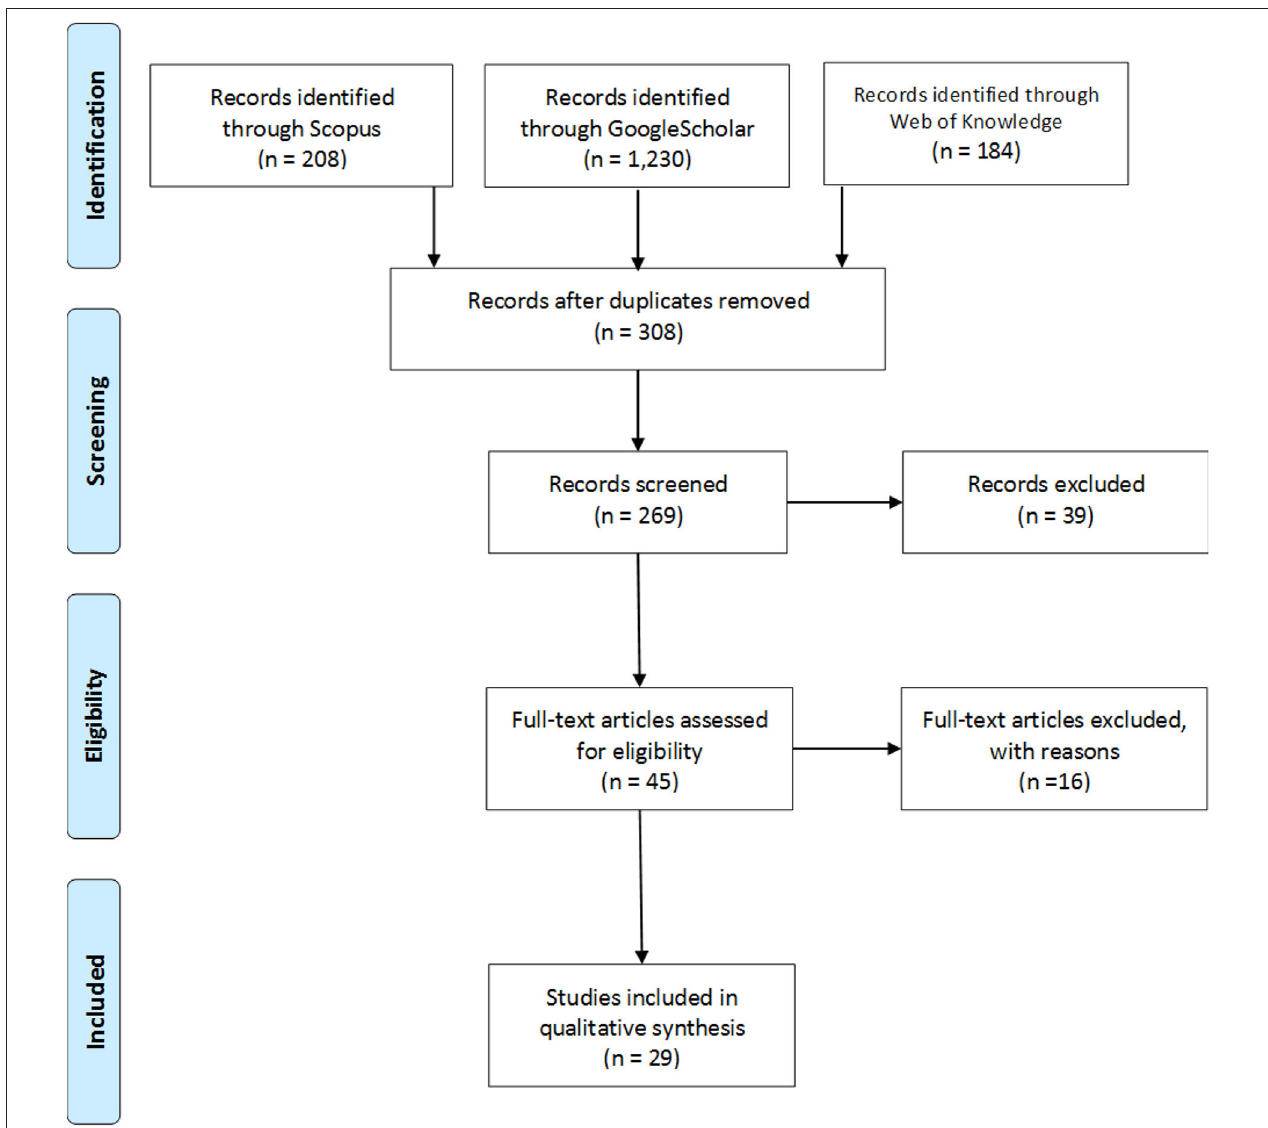
FIGURE 1 | PRISMA flow diagram. This figure illustrates the steps taken in conducting the systematic review.